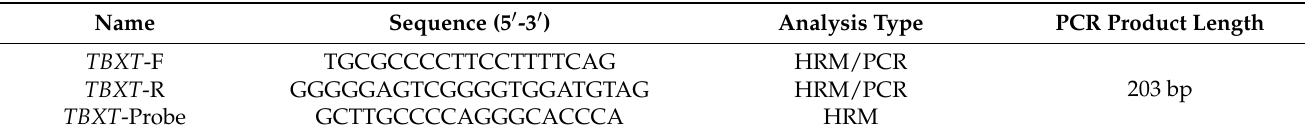
Table 1. Primers used in HRM and Sanger sequencing.